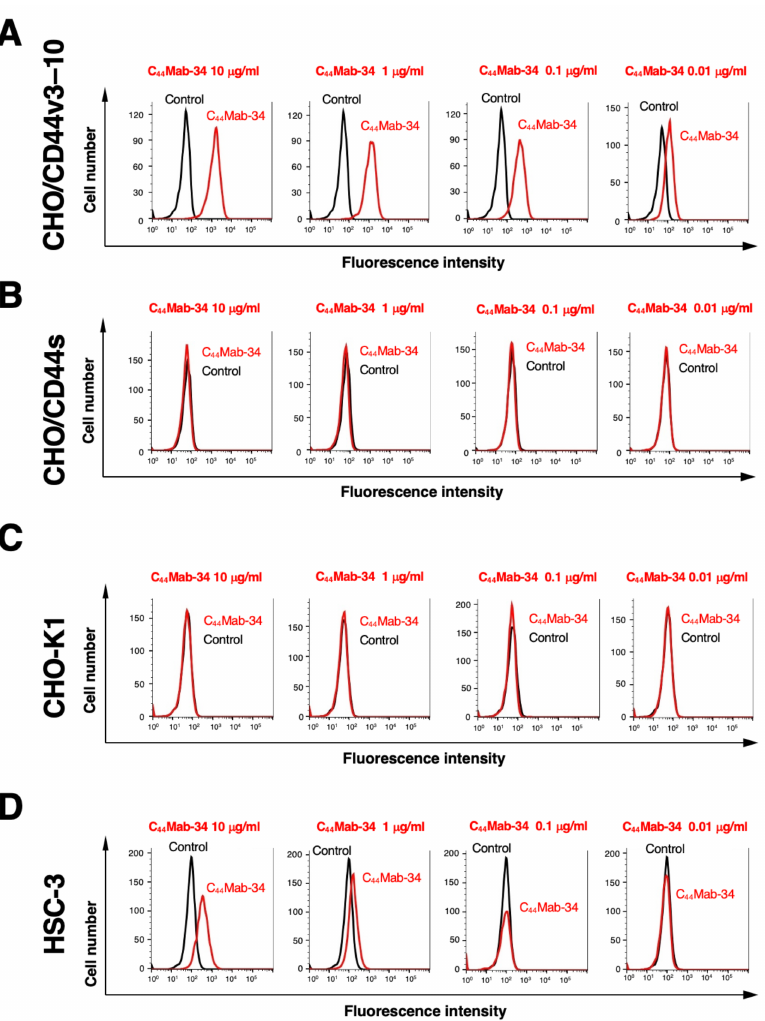
Figure 2. Flow cytometry using C 44 Mab-34 against CD44-expressing cells. CHO/CD44v3–10 ( A ), CHO/CD44s ( B ), CHO-K1 ( C ), and HSC-3 ( D ) cells were treated with C 44 Mab-34, followed by treatment with anti-mouse IgG conjugated with Alexa Fluor 488 (red line). The black line represents the negative control (blocking